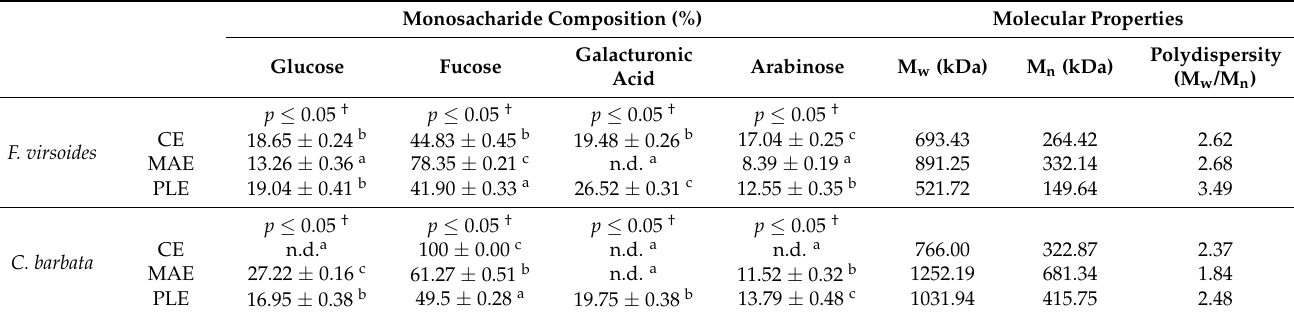
Table 5. Monosaccharide composition and molecular properties (weight average molecular weight—M w ; number average molecular weight—M n ; polydispersity index—PDI) of CE (conventional), MAE (microwave), and PLE (pressurized liquid) extracted polysaccharides from Fucus virsoides and Cystoseira barbata . Monosacharide Composition (%) Molecular Properties Polydispersity Galacturonic Arabinose M w (kDa) M n (kDa) Glucose Fucose (M w /M n Acid